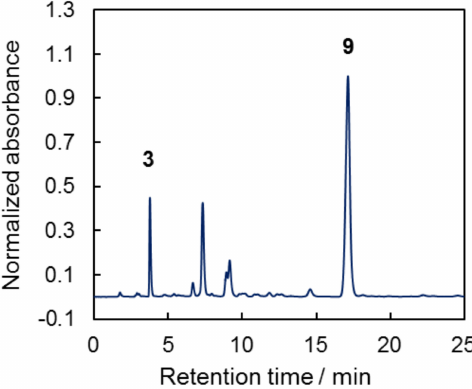
Figure 7. Chromatogram of curing product of 7 .